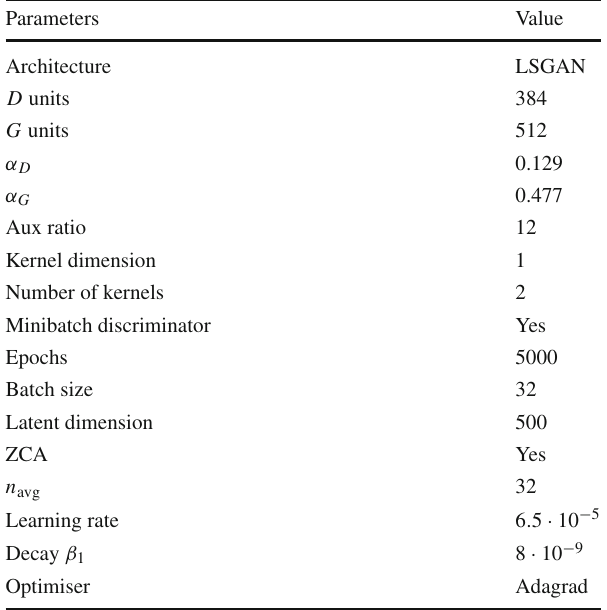
Table 1 Final parameters for the gLund model